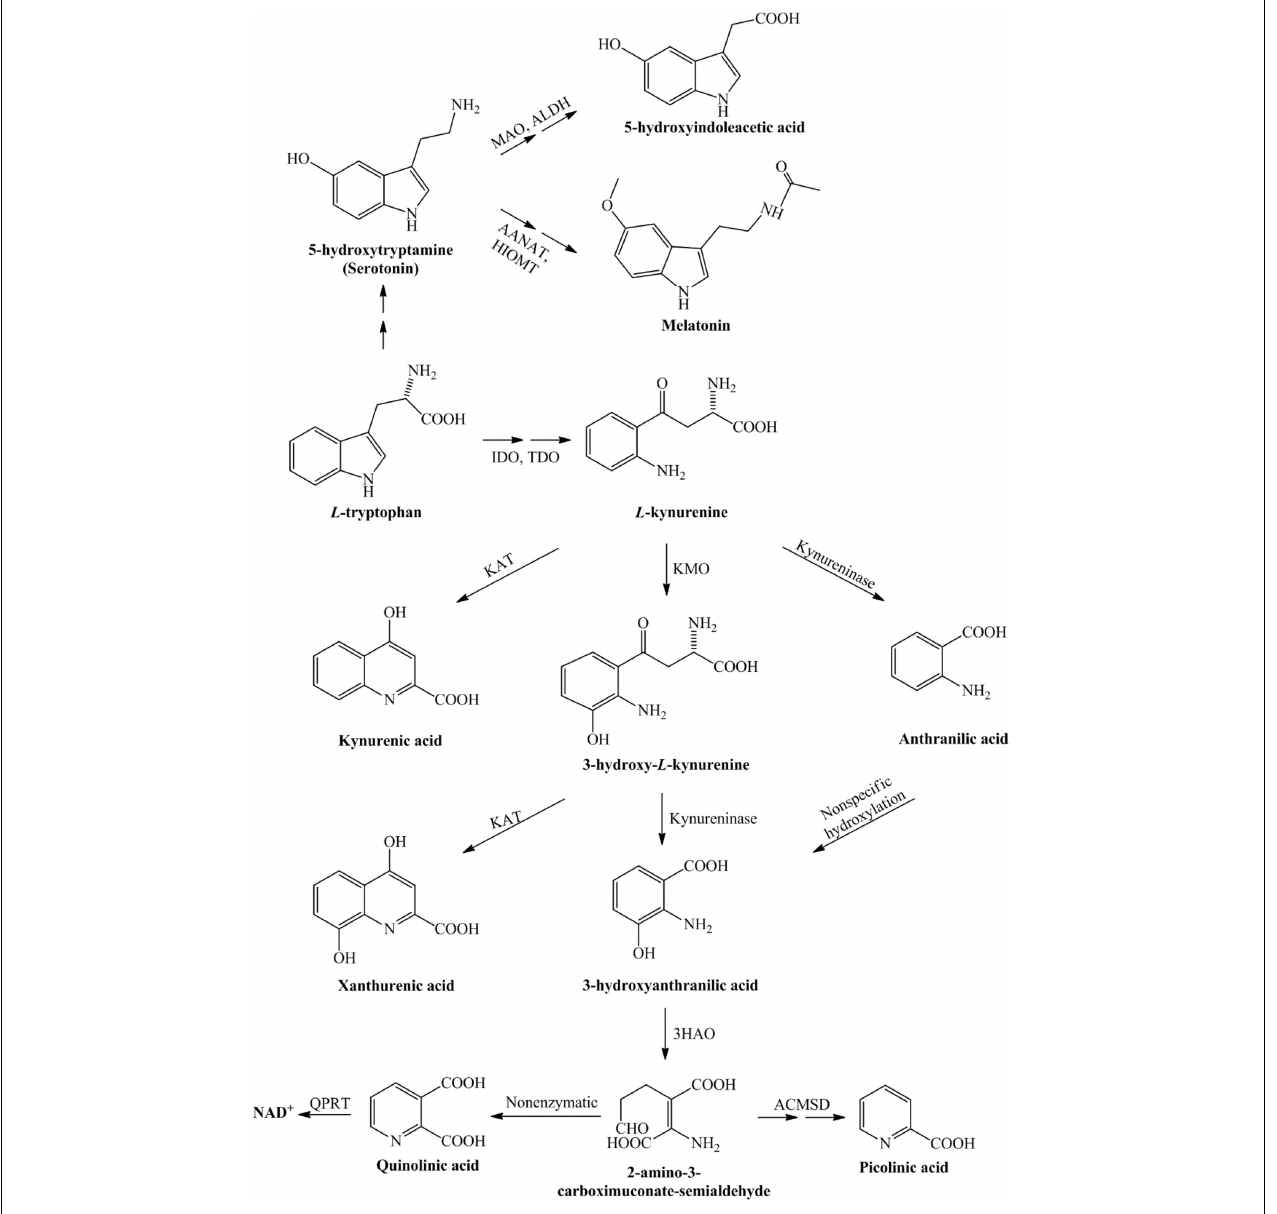
FIGURE 1 | Detailed representation of the kynurenine pathway. Tryptophan, as an essential amino acid, is a precursor of the serotonin- and kynurenine pathway. During the serotonin pathway, melatonin and 5-hydroxyindoleacetic acid are formed, while the kynurenine pathway of tryptophan metabolism leads to the production of nicotinamide adenine dinucleotide. The conversion of tryptophan to L -kynurenine is performed by IDO/TDO. From L -kynurenine various neuroactive metabolites are formed during this pathway, which eventually leads to the nicotinamide adenine dinucleotide, that plays a significant role in the production of cellular energy. 3-HAO, 3-hydroxyanthranilate oxidase; AANAT, arylalkylamine N -acetyltransferase; ACMSD, α -amino- β -carboxymuconate-semialdehyde-decarboxylase; ALDH, aldehyde dehydrogenase; HIOMT, hydroxyindole- O -methyltransferase; IDO, indoleamine 2,3-dioxygenase; KAT, kynurenine aminotransferase; KMO, kynurenine 3-monooxygenase; MAO, monoamine oxidase; NAD + , nicotinamide adenine dinucleotide; QPRT, quinolinate phosphoribosyltransferase; TDO, tryptophan 2,3-dioxygenase.